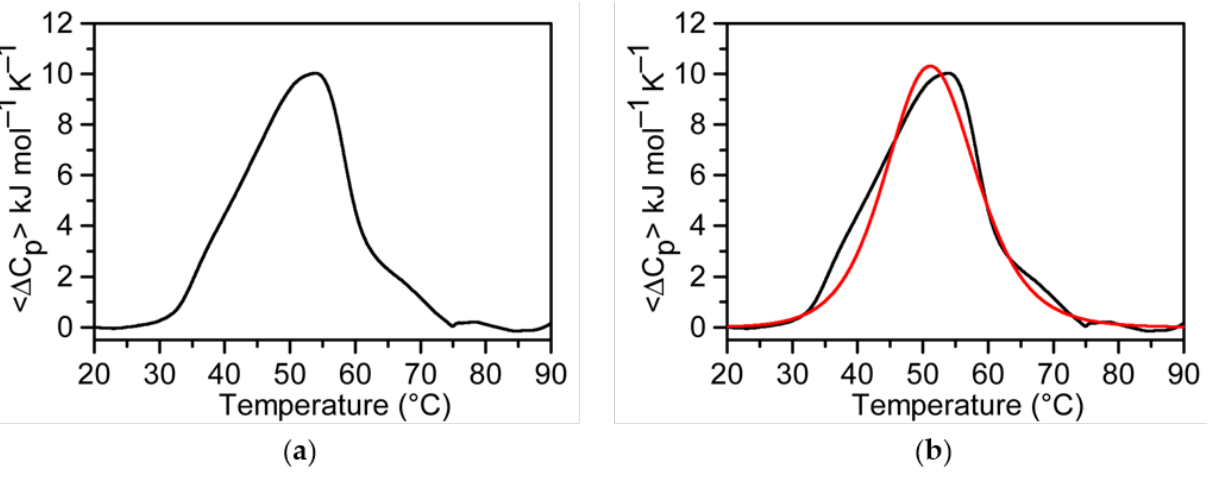
Figure 2. DSC analysis of MS3 in the Na + -containing buffer (10 mM NaH 2 PO 4 /Na 2 HPO 4 , 90 mM NaCl solution, pH 7.0). ( a ) Experimental DSC profile (black line), and ( b ) Van ’t Hoff calculated curves based on the two-states model (red line) superimposed on the experimental curve (black line). Table 1. Thermodynamic parameters of MS3 determined by DSC and CD measurements in the se- lected Na + -containing buffer (10 mM NaH 2 PO 4 /Na 2 HPO 4 , 90 mM NaCl solution, pH 7.0) .